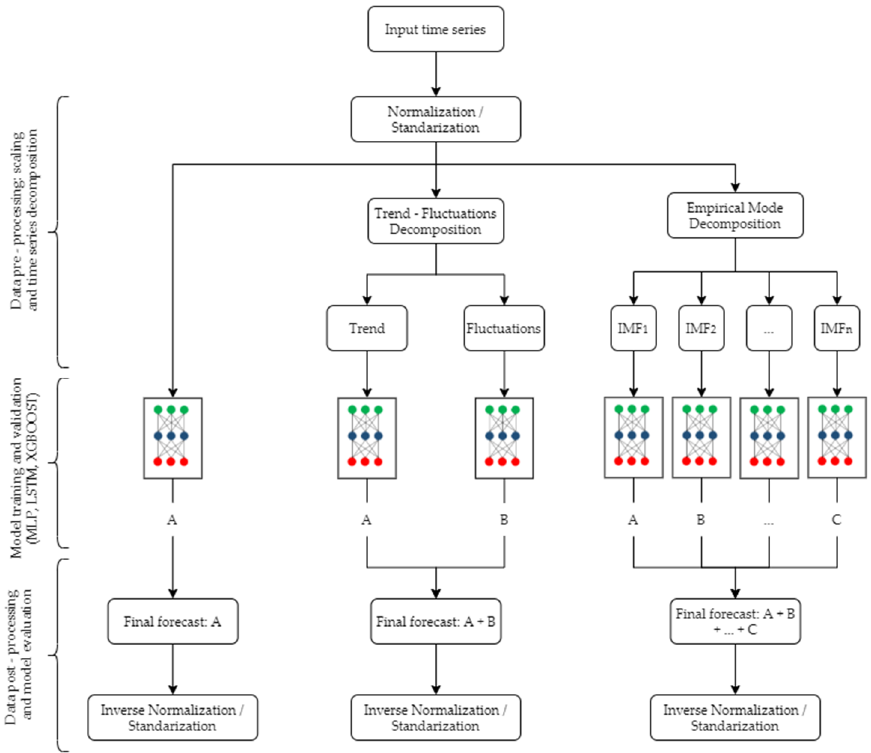
Figure 4. Flowchart of the different actions carried out in the forecasting process.